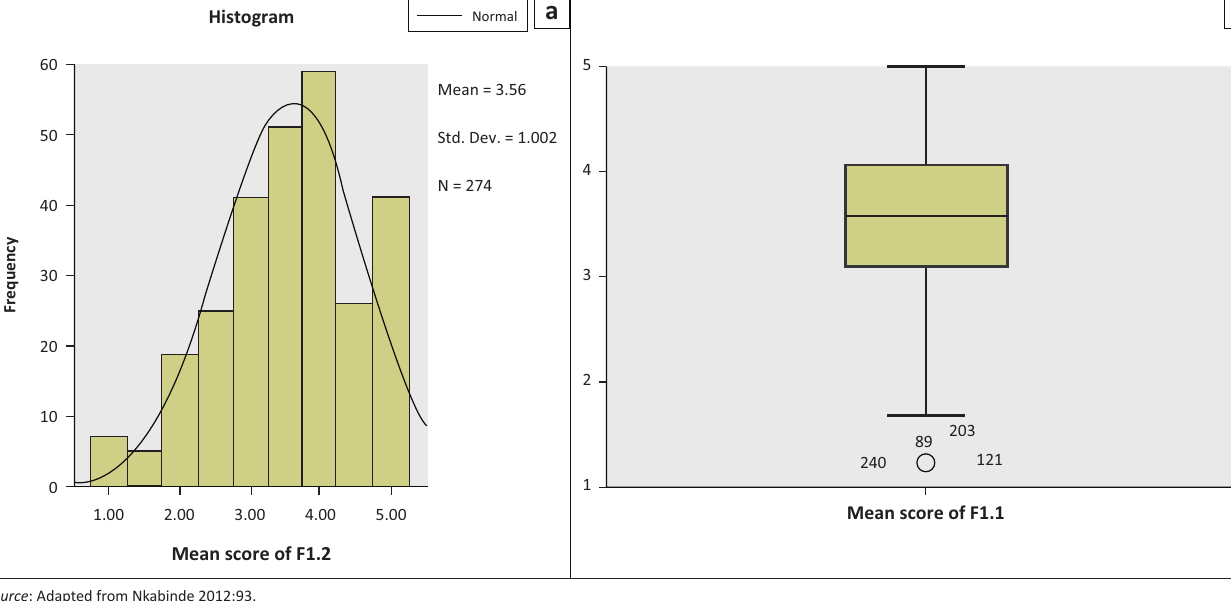
FIGURE 2: The histogram (a) and box plot (b) of the items in ‘The parent’s motivation of learner performance in the Foundation Phase’